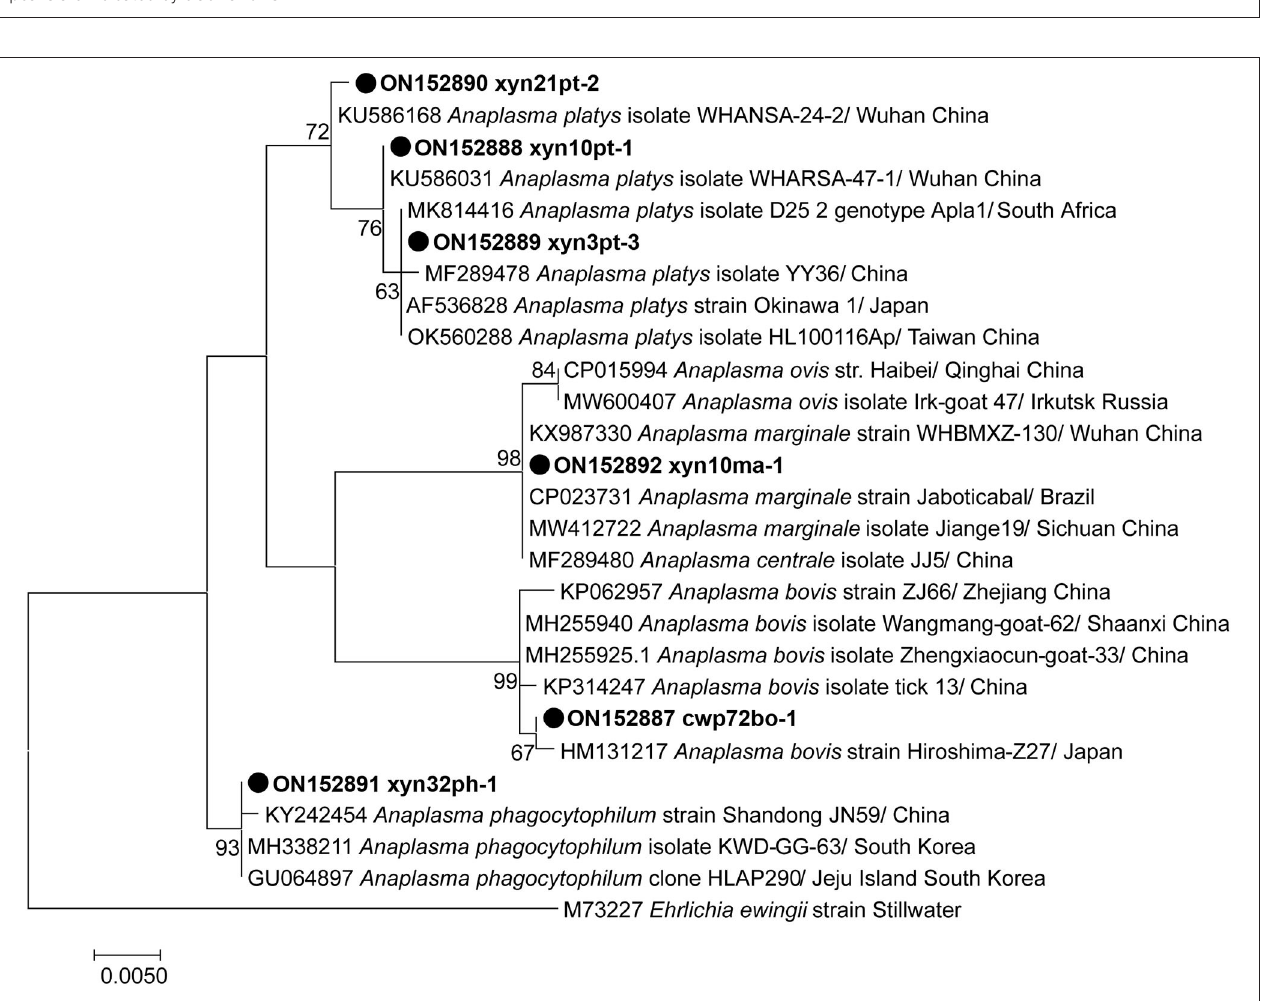
Frontiers in Microbiology |